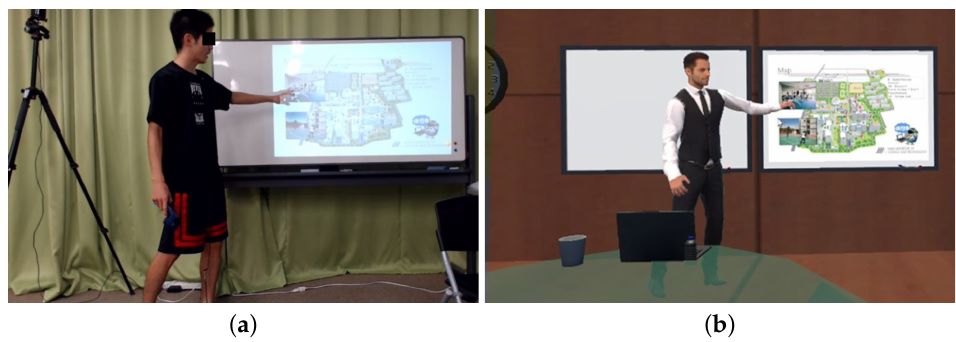
Figure 4. Example of the system view. ( a ) Recorded user in the presentation mode. ( b ) Corresponding avatar in the playback mode.